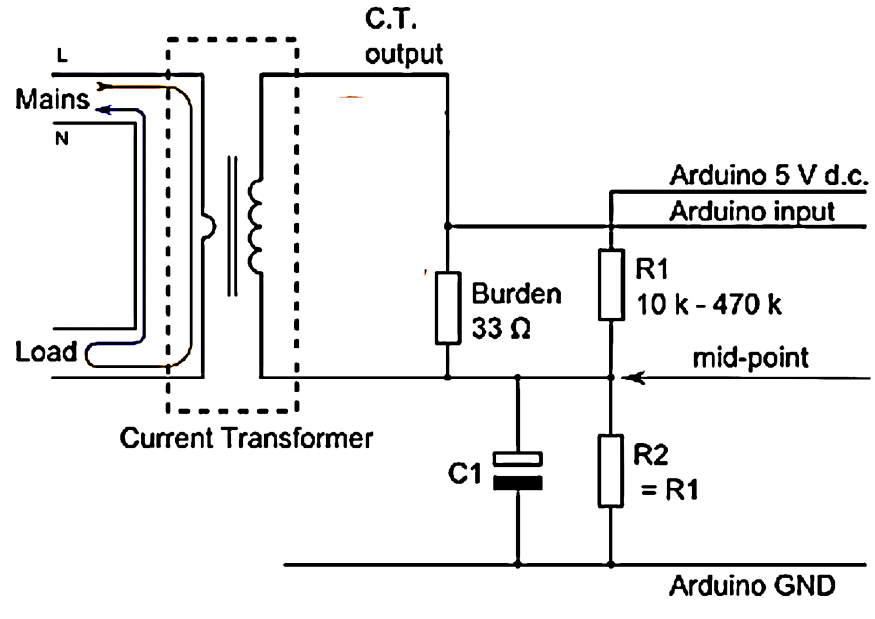
Figure 4. Current sensor circuit [37].